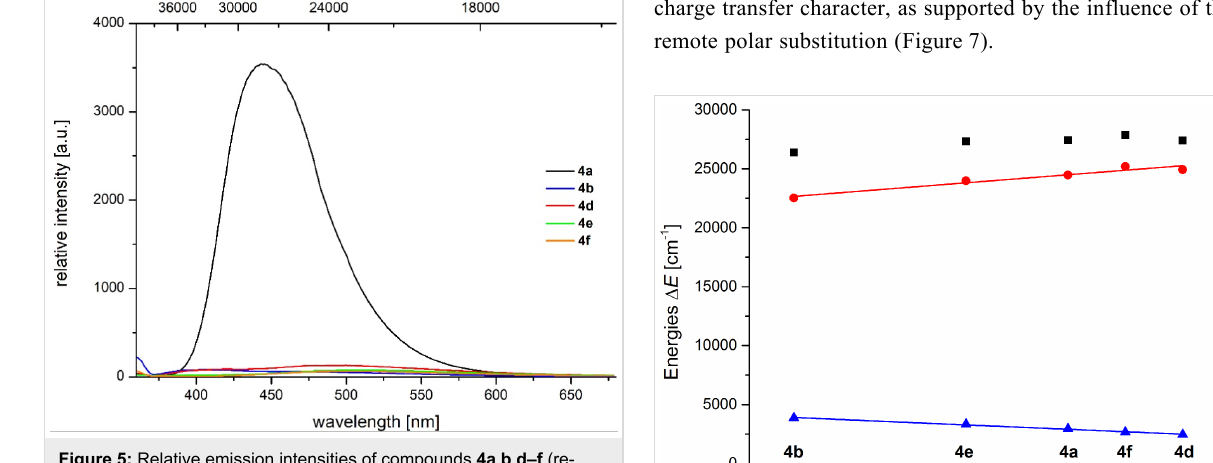
Figure 5: Relative emission intensities of compounds 4a , b , d–f (re- corded in CH 2 Cl 2 UVASOL ® at T = 293 K; λ exc = 350 nm.